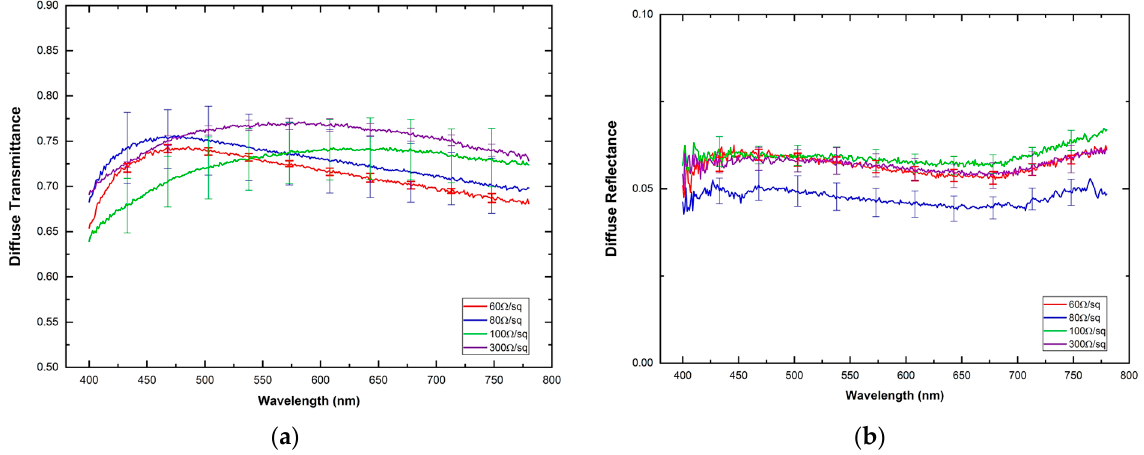
Figure 3. Spectral diffuse reflectance ( a ) and diffuse transmittance ( b ) for each one of the ITO-PET electrodes. Solid lines correspond to the mean value extracted from the measurements and their standard deviation is also indicated as vertical lines.